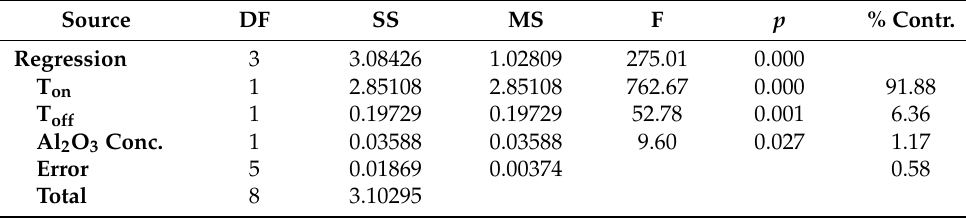
Table 4. ANOVA for